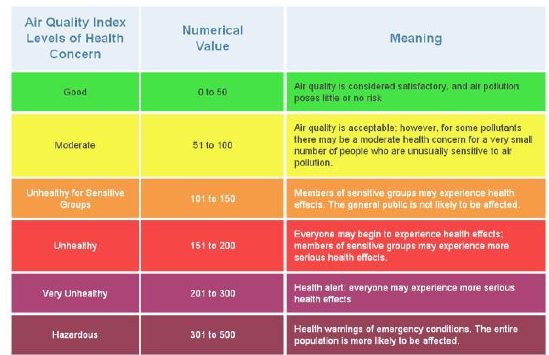
Table 1. Air Quality Index